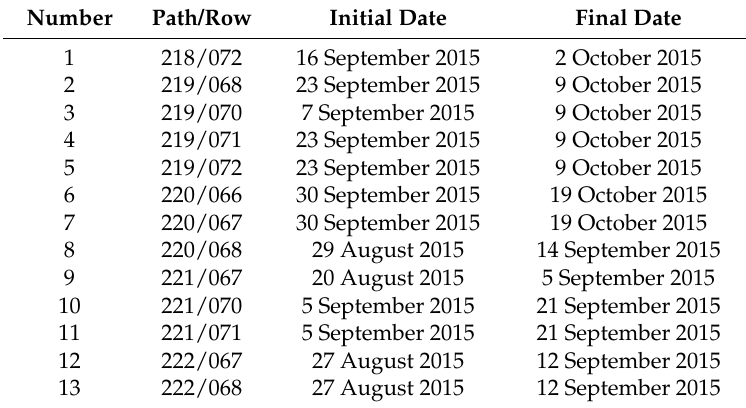
Table 1. Landsat 8 path/rows and dates used to elaborate reference fire